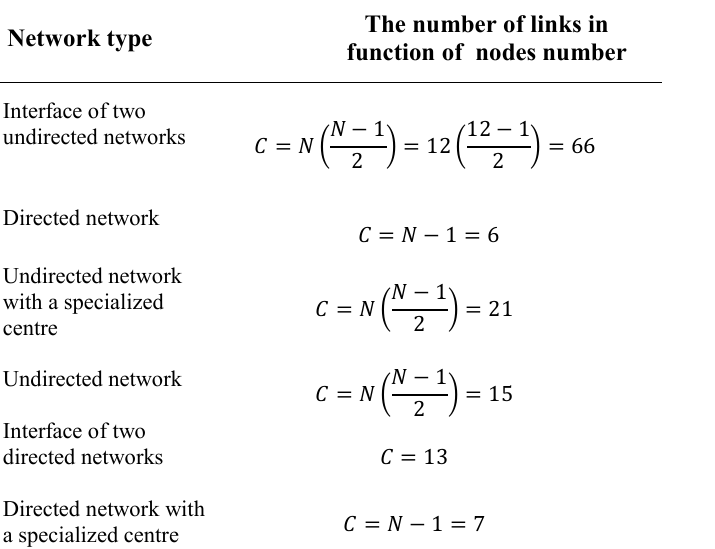
Table 1. The number of links in the function of nodes number for specific network type given in Figure 1 Network type